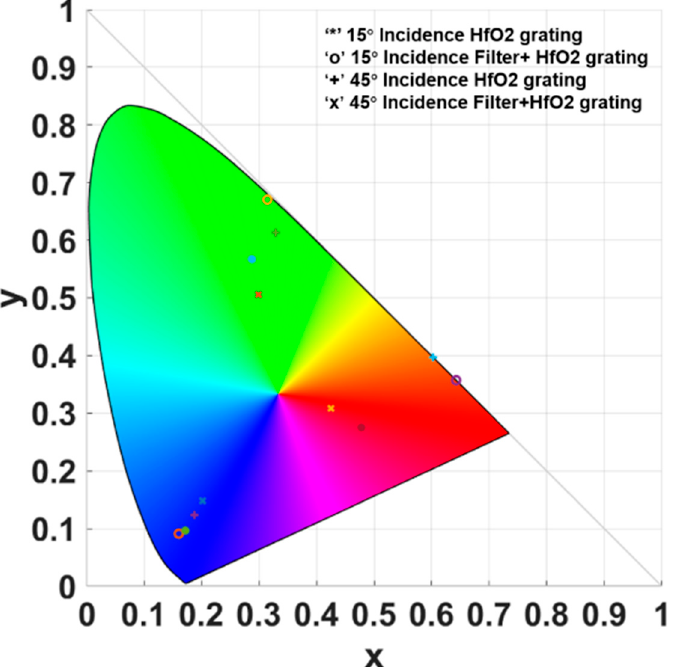
Figure 5. The distribution of chromaticity coordinates of the HfO 2 grating and the “filter + HfO 2 grating” on the CIE 1931 chromaticity diagram at the incident angles of 15° and 45°. The structural colors obtained by several combinations were compared, as shown in Figure 6. Figure 6a,b are the blue, green, and red obtained by the HfO 2 grating and the “Filter + HfO 2 grating” at 15° and 45° incident angles, respectively. The highest quality of structural color was obtained with the “Filter + HfO 2 grating” at an incident angle of 15°. The red and green qualities obtained by the four combinations were from high to low: “15° + Filter + HfO 2 grating” > “45° + Filter + HfO 2 grating” > “15° + HfO 2 grating” > “45° + HfO 2 grating”. The blue produced by both combinations at 45° incidence were of lower quality than the blue obtained at 15°.